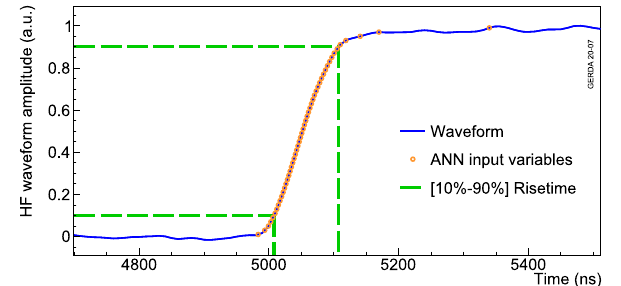
Fig. 11 Zoom on a typical normalized 100 MHz trace of a coaxial detector. The 50 ANN input variables (red circles) and rise time esti- mates (dashed green) are indicated